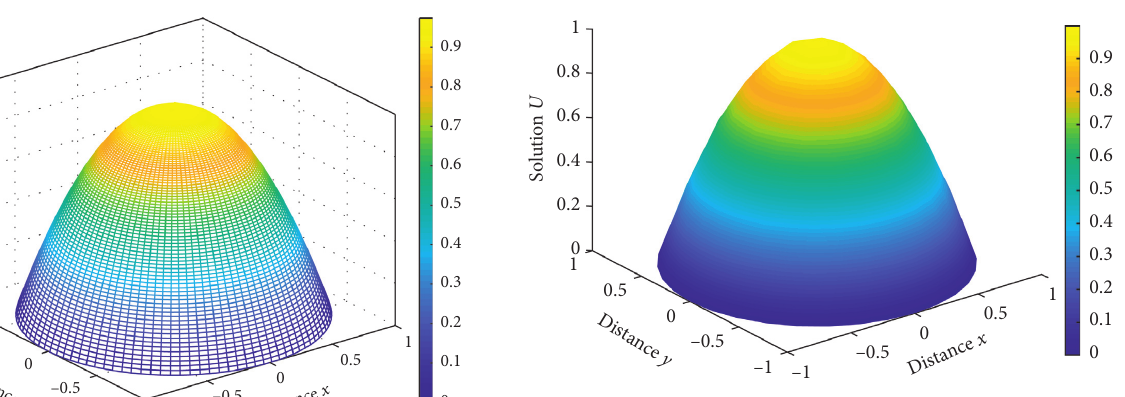
Figure 8: Approximated solution using finite element method.